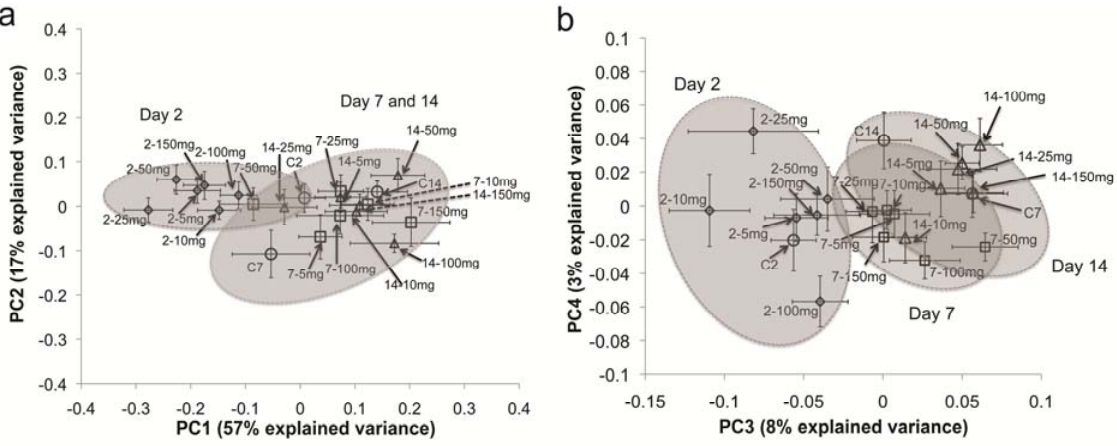
Figure 2. Average principal component analysis (PCA) score plot for the 1 H NMR spectra of Eisenia fetida tissue extracts after PFOS exposure of two, seven and fourteen days. ( a ) PC1 (first PCA component) versus PC2 (second PCA component), ( b ) PC3 (third PCA component) versus PC4 (fourth PCA component). The mean scores for the PFOS-exposed earthworms are denoted by the exposure length, followed by the corresponding exposure concentration (for example, 2–50 denotes a two-day exposure to 50 mg/kg of PFOS in Organization for Economic Corporation and Development soil). The mean scores (with associated standard error) were obtained by averaging the scores of the controls and each exposure concentration for each day of exposure. The ellipses were constructed as visual